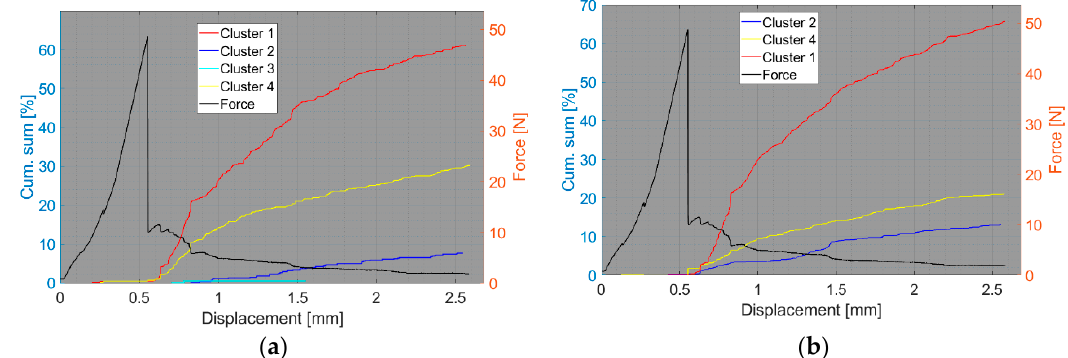
Figure 17. Cumulative sum of hits of individual clusters, including force versus displacement—UCT samples: ( a ) Fujicera 1045S dataset; ( b ) DWC 454 dataset.